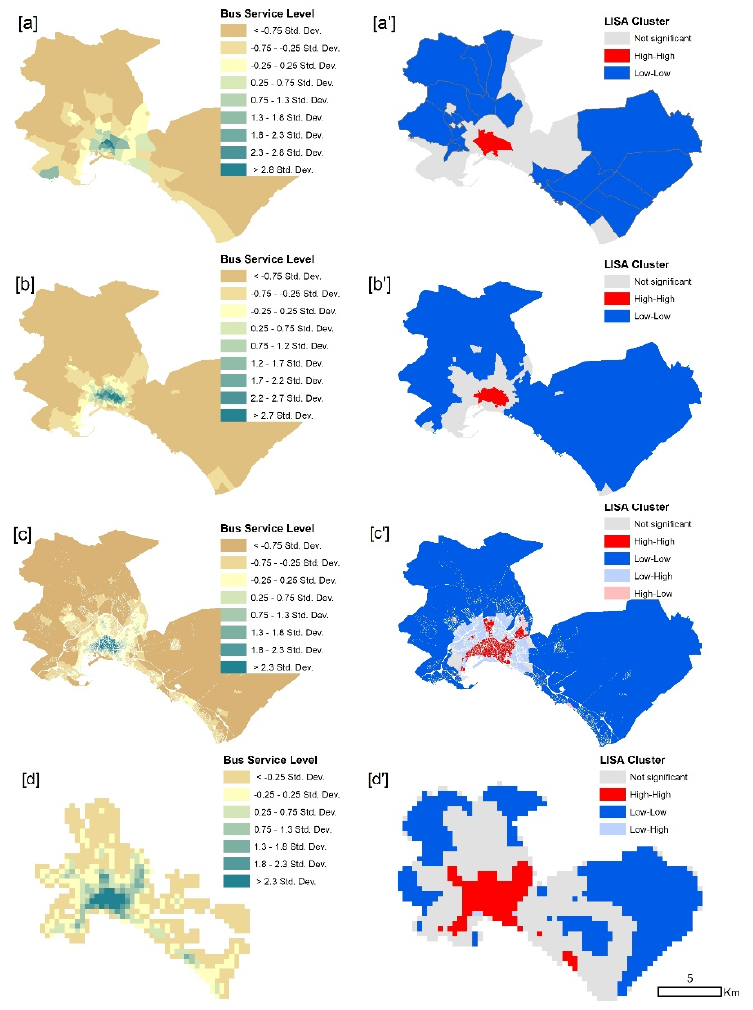
Figure 5. Bus service level and Local Moran’s distribution (significance < 0.05): ( a , a′ ) Neighbour- hoods; ( b , b′ ) Census sections; ( c , c′ ) Cadastral blocks; and ( d , d′ ) 400 × 400 m mesh.